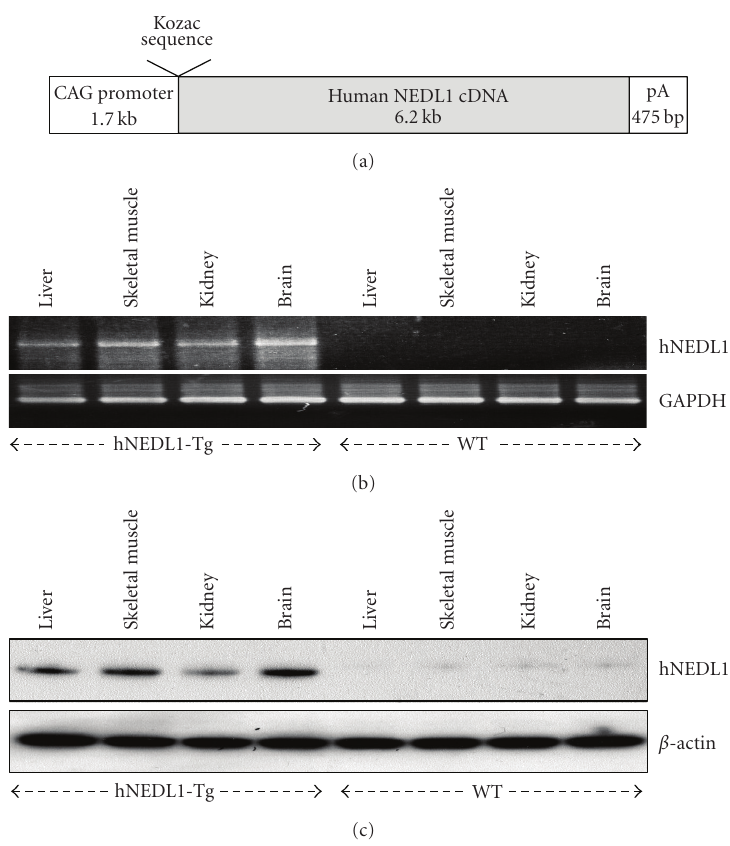
Figure 1: Characterization of CAG/hNEDL1 transgenic mice. (a) Schematic representation of CAG/hNEDL1 construction, in which CAG promoter contains the cytomegalovirus enhancer and a chicken β -actin promoter and intron. (b) Semiquantitative RT-PCR analyses of the RNA samples extracted from liver, skeletal muscle, kidney, and brain of both wild-type and transgenic mice were carried out and GAPDH was used as control in this test. (c) Western blotting analyses of human hNEDL1 protein in di ff erent tissues of both wild-type and hNEDL1-Tg mice were carried out and β -actin was used as loading